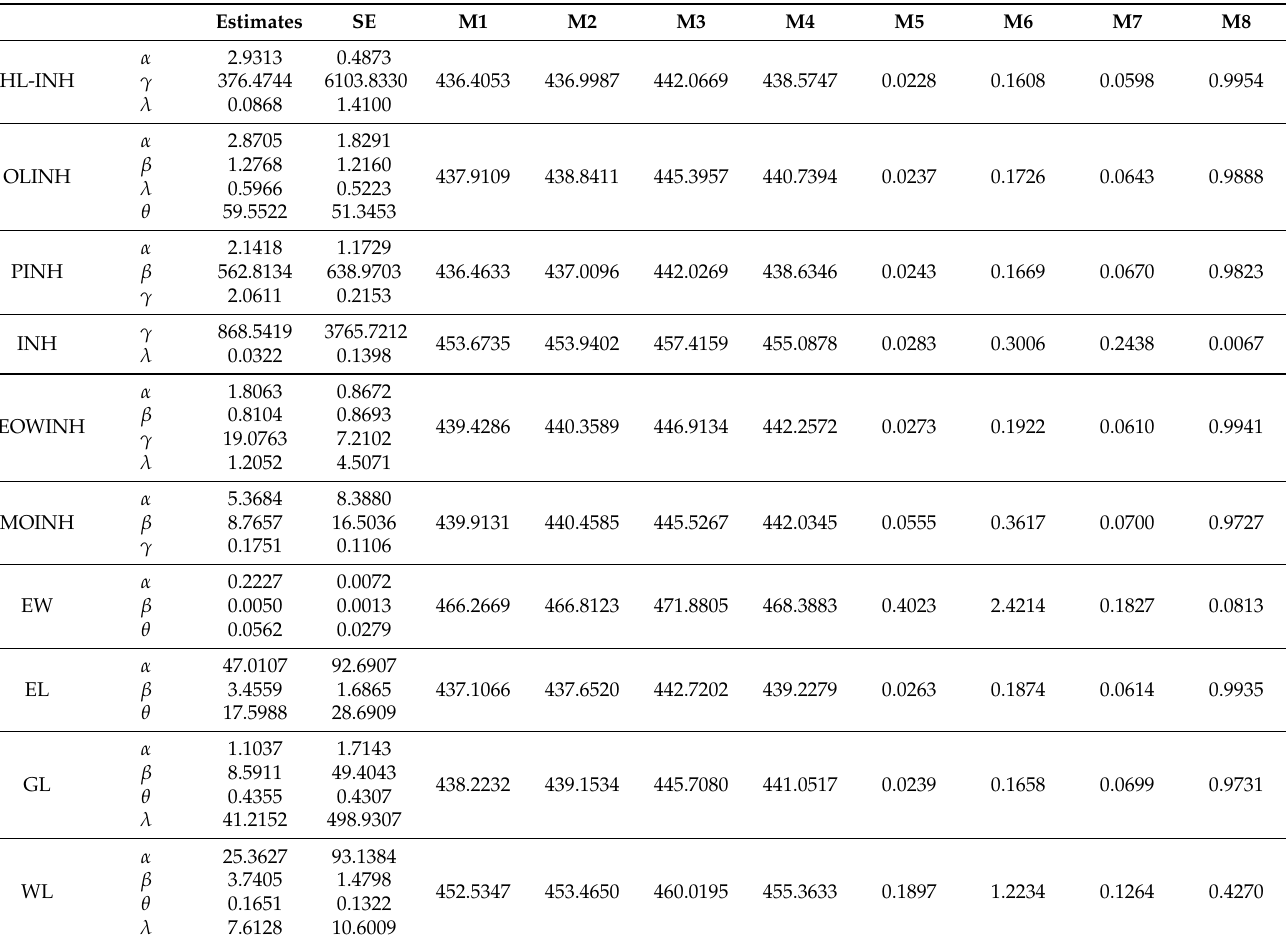
Table 9. MLE for each model with different measures: flood